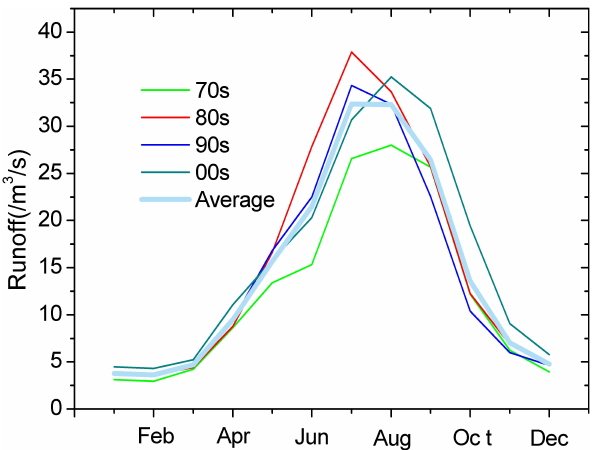
Fig. 9. Average monthly runoff changes of QiLian station.